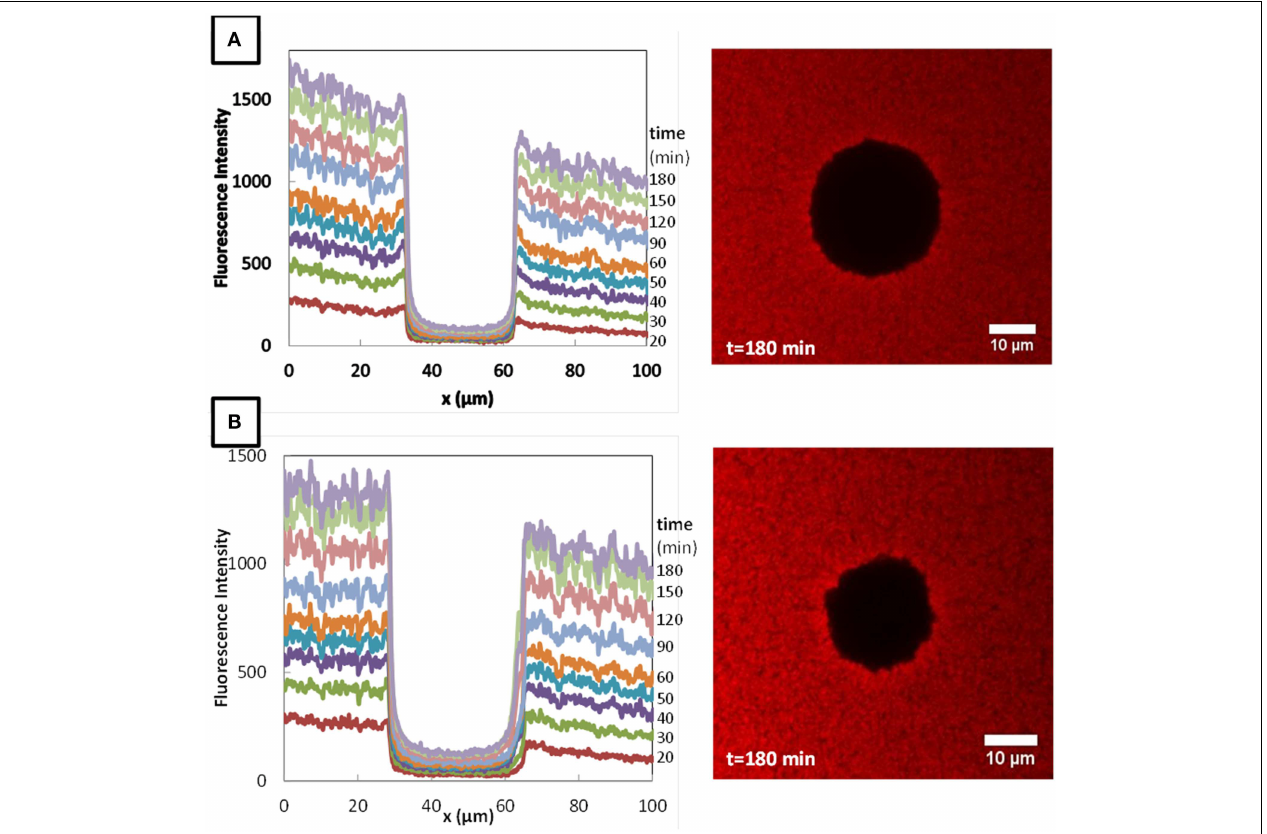
FIGURE 9 | Fluorescence profiles of RITC- α S1 -casein in Lactococcus lactis LD61 (A) and TIL1230 (B) from 20 to 180min and corresponding microscopic observations of the colony after 180min of